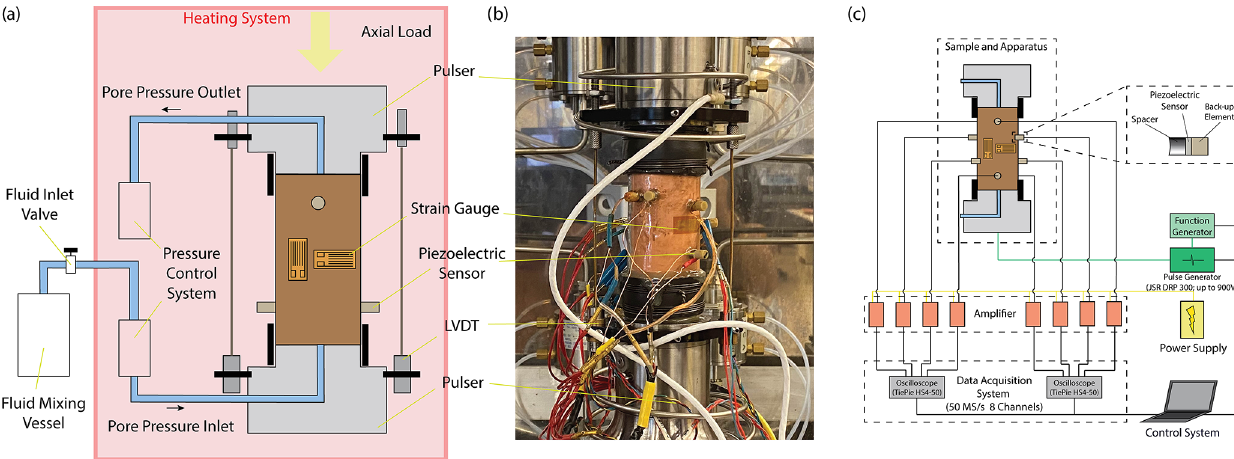
Figure 2. (a) Schematics of sample configuration. The whole sample assembly and pore fluid actuators are enclosed in a servo-controlled heating system to ensure a uniform temperature condition. (b) Photo of the sample assembly. (c) Illustration of the acoustic emission recording